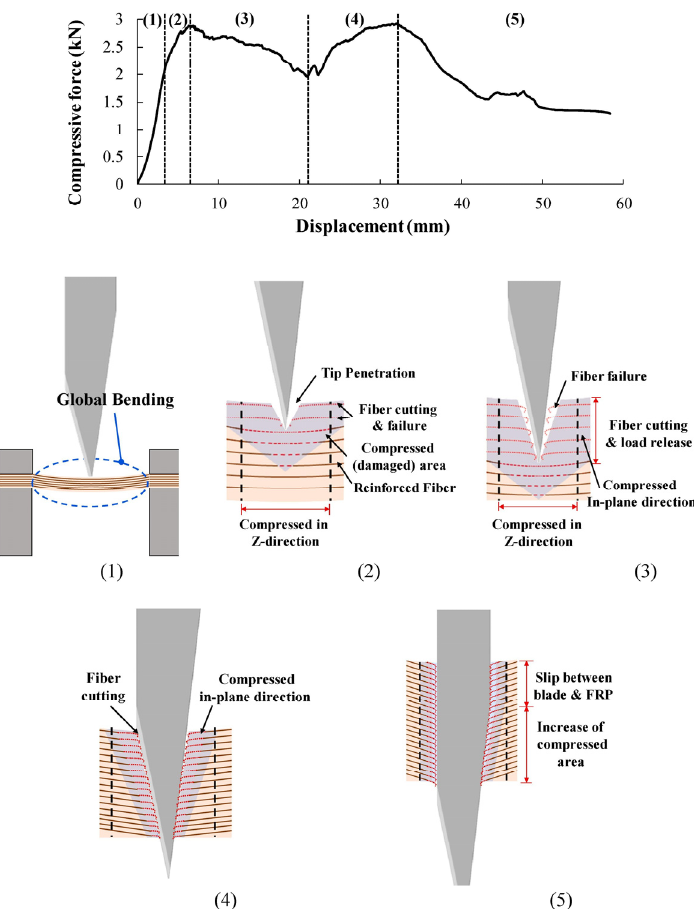
Figure 8. Blade penetration and stab resistance mechanism of the fiber-reinforced polymer composites. Numbers (1) – (5) correspond to the positions marked in the upper diagram. Reprinted from [61], Copyright (2020), with permission from Elsevier.